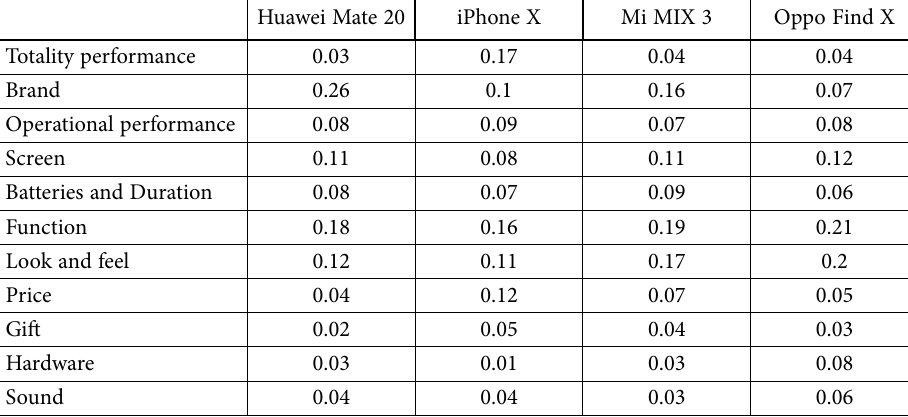
Table 11. The average weight matrix of the three weight matrices